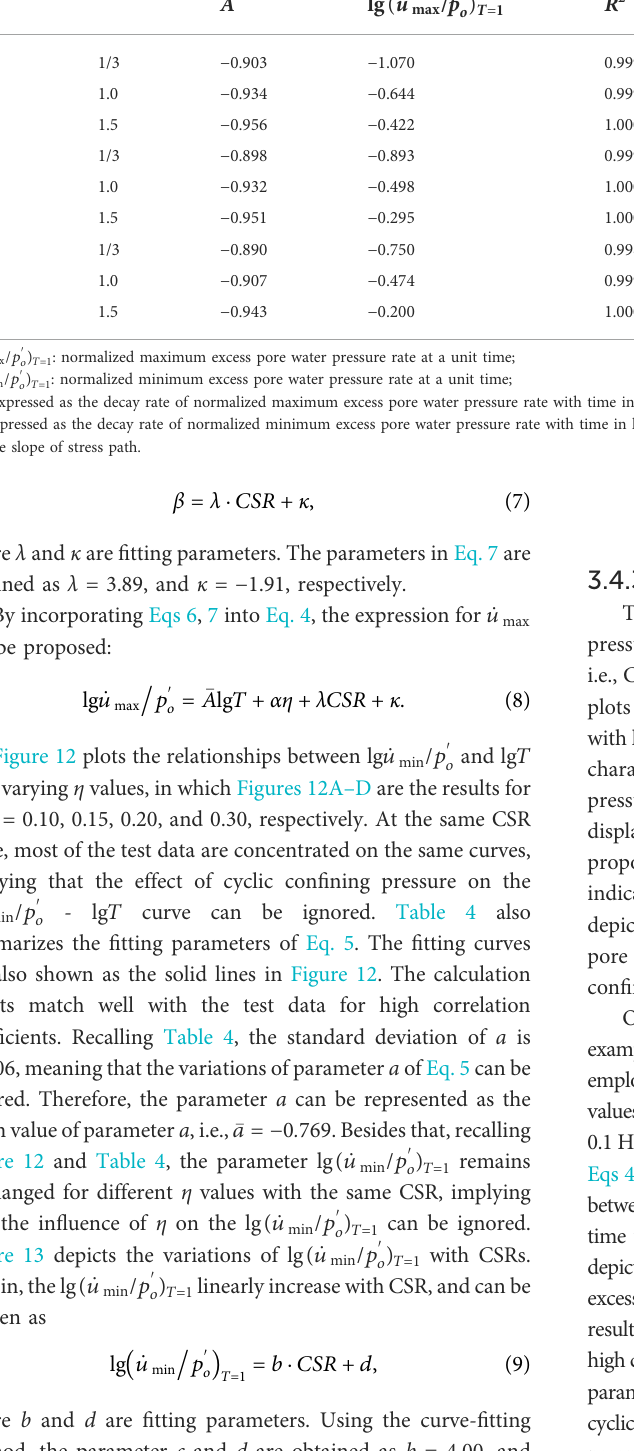
where b and d are fi tting parameters. Using the curve- fi tting method, the parameter c and d are obtained as b = 4.00, and d = − 2.23, respectively.